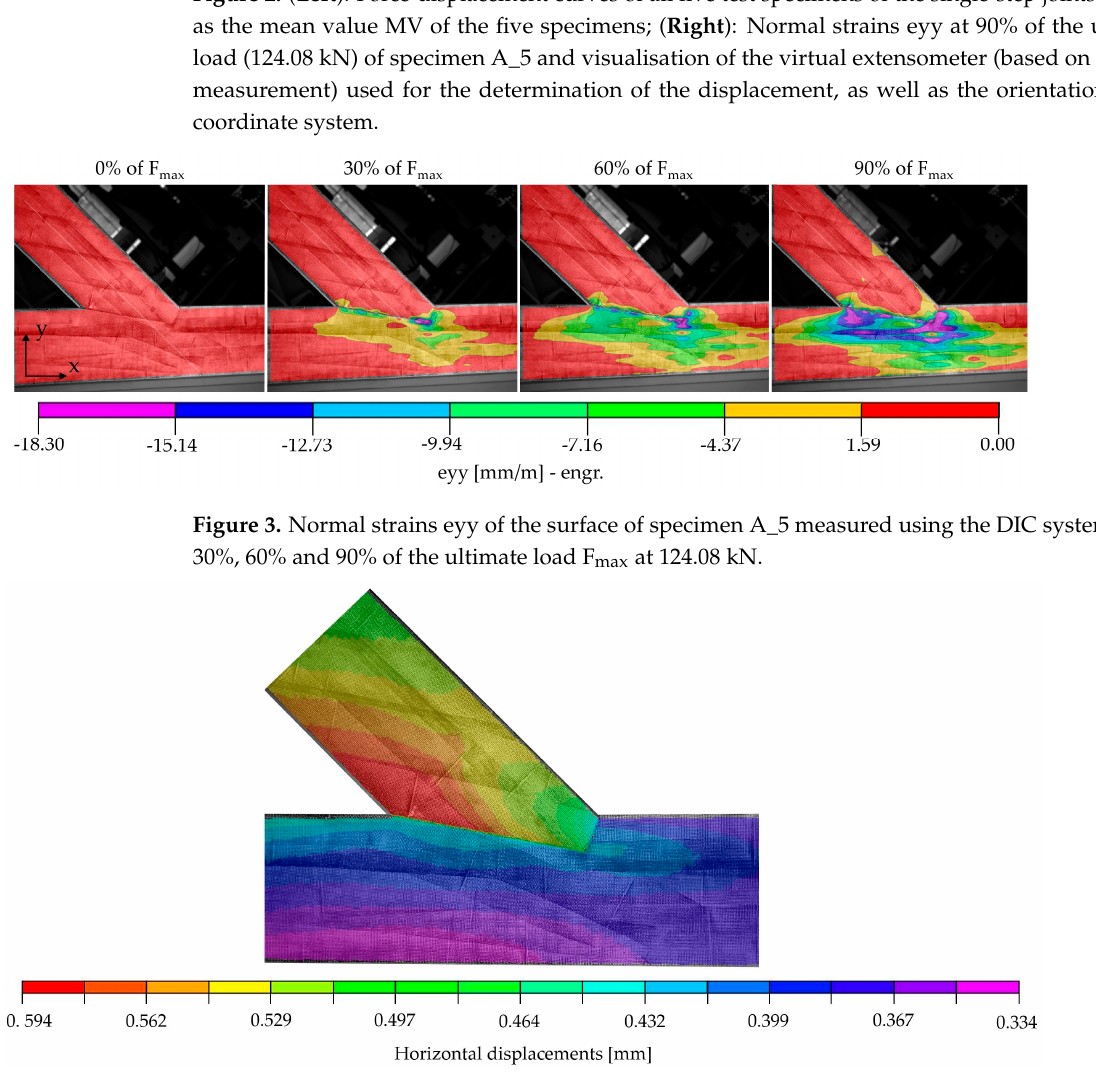
Figure 4. DIC-horizontal displacements on the surface of specimen A_5 at 70.1 kN.